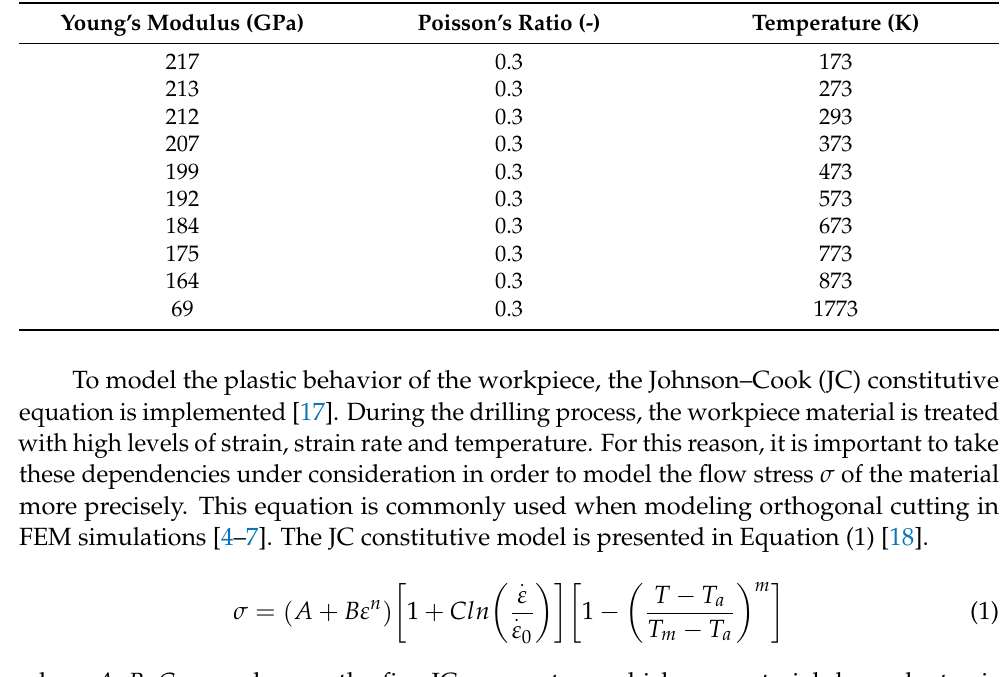
Table 1. Elastic properties of DIN 42CrMo4